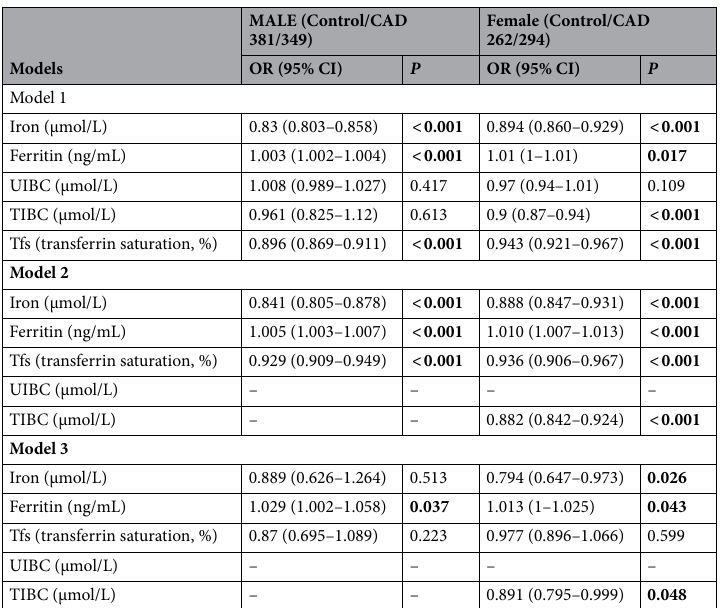
Table 3. Associations of iron metabolic markers and CAD. Model 1 is crude model without any onfounders. Model 2 was adjusted for age, BMI, SBP, DBP, Heart ratio, smoking habit, alcohol drinking habit, hypertension, diabetes status, dyslipidemia, medicine and family history of CAD. Model 3 additionally adjusted for HbA1C, ALT, AST, TCHO, TG, hsCRP, eGFR. Significant values are in